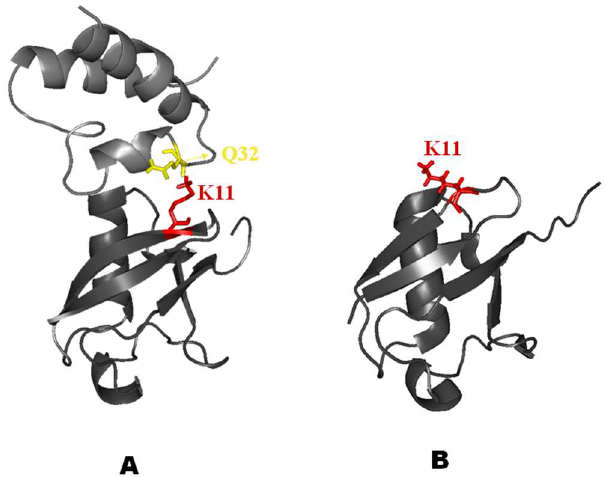
Figure 11. Molecular details of the interaction between CUBAN domain and NEDD8 as revealed by 15 N HSQC NMR. ( A ) Possible intermolecular bridge due to a H-bond between the CO of Q32 of CUBAN and the NH+ of K11 of NEDD8. ( B ) Difference in local flexibility of K11 due to its the structure in ubiquitin with respect to NEDD8 (see text for details).